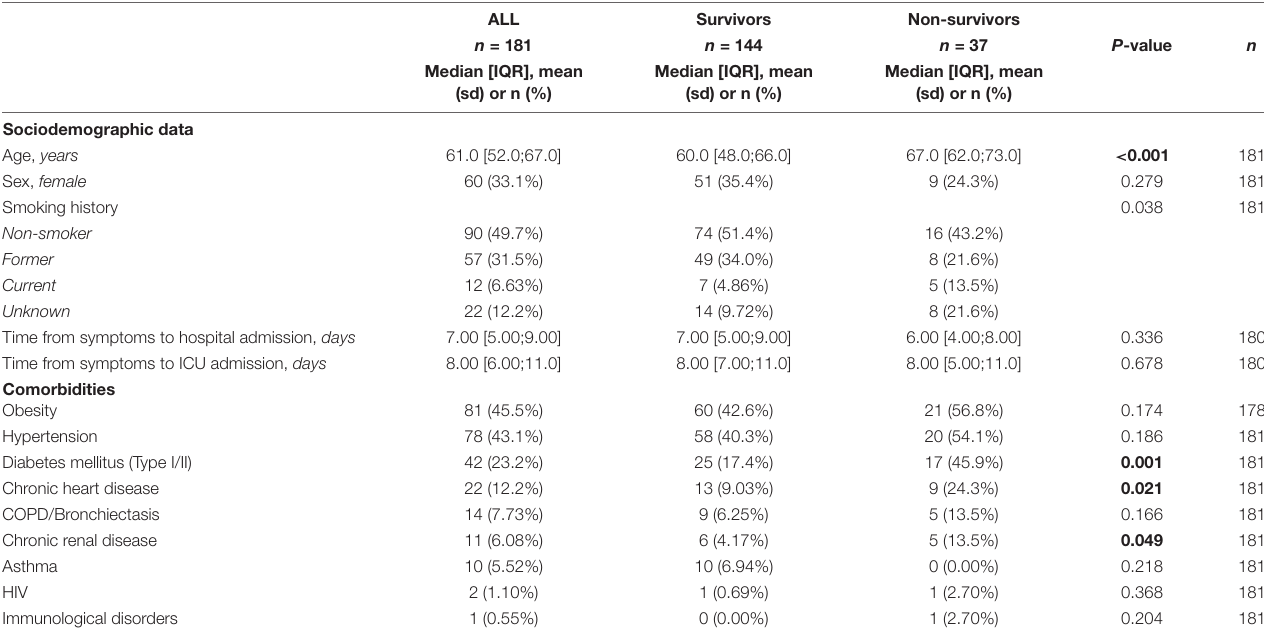
TABLE 1 | Baseline